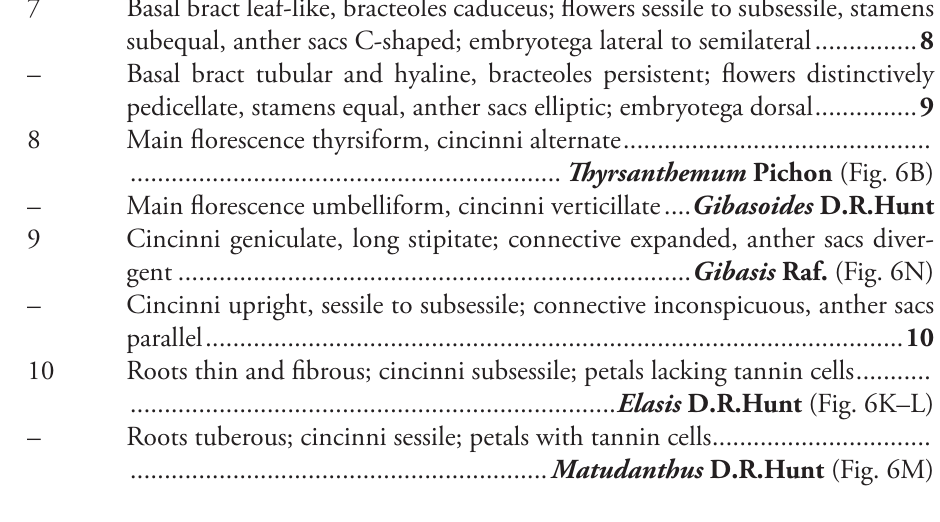
Fig. 6L Tradescantia guatemalensis C.B.Clarke ex Donn.Sm., Bot. Gaz. 18(6): 210. 1893. Lec- totype (designated here). GUATEMALA. Jalapa: Laguna de Ayarza, fl., fr., Sep 1892, Heyde & Lux 3886 (US barcode US00045211!; isolectotypes: NY barcode NY00039636!, P barcode